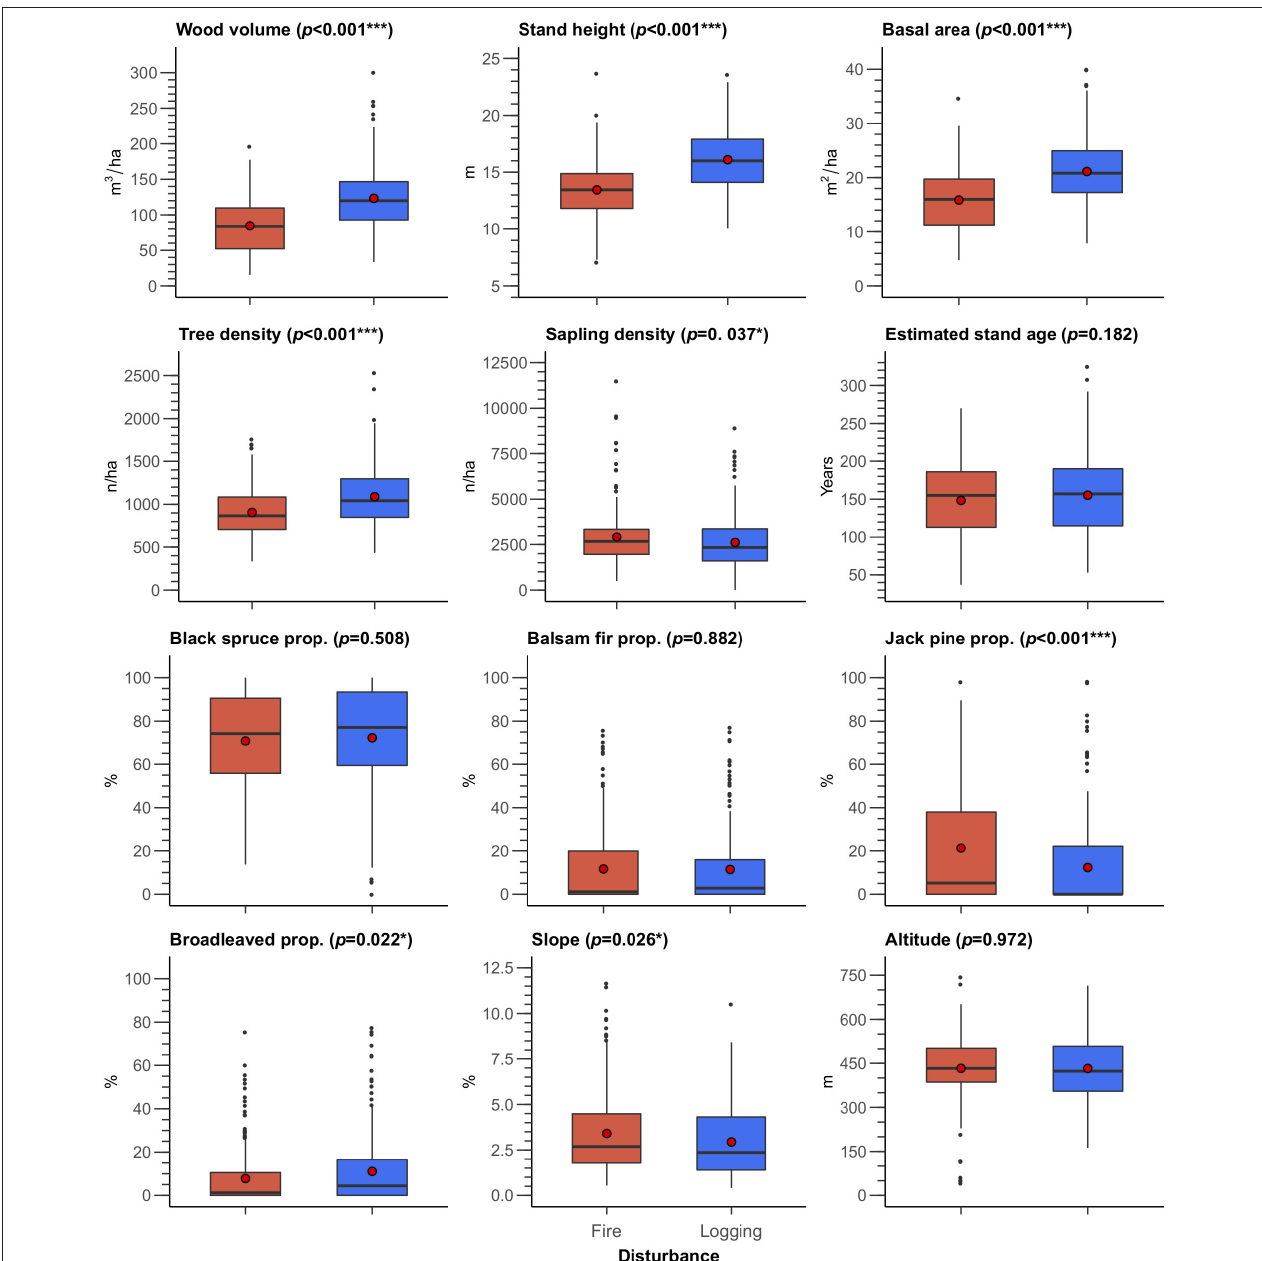
FIGURE 2 | Boxplot of the transect attributes by disturbance type: fire (red) and logging (blue). Red dots represent mean values. Prop., proportion; p , p -values of the nested PERMANOVA test; “*” indicates p < 0.05, “**” p < 0.01, and “***” p < 0.001. Details of the nested PERMANOVA tests are provided in Appendix A .